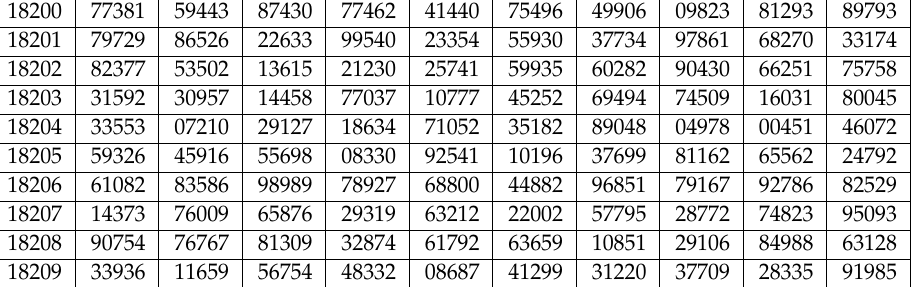
Table A1. Table of Seed